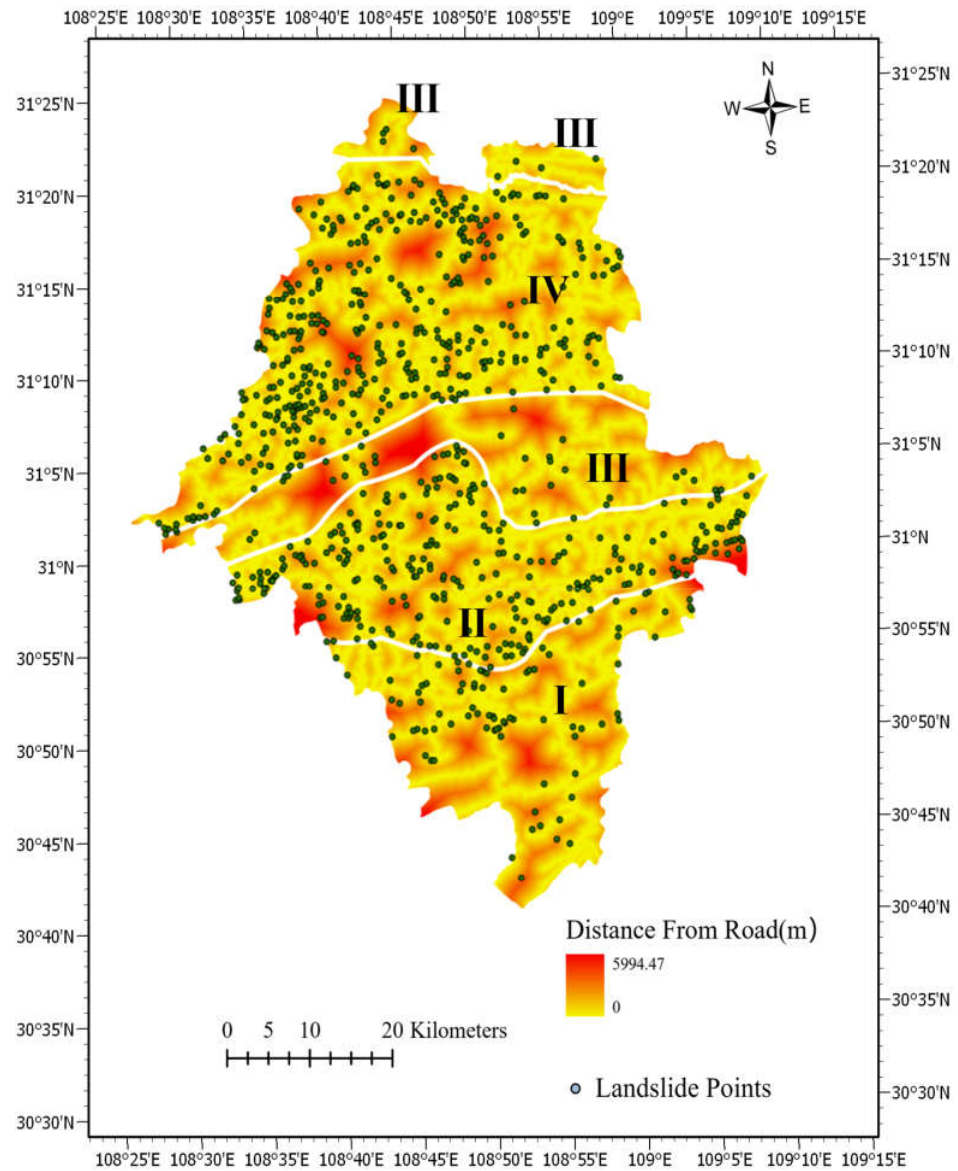
Figure 3. Landslides distribution versus distance from road in different sub-zones.